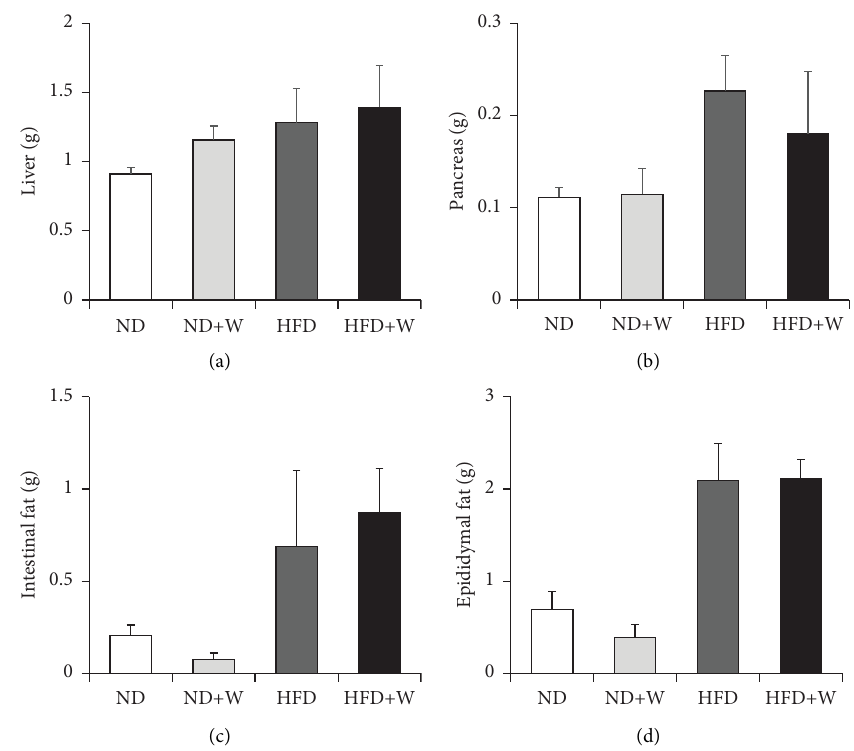
Figure 4: Weight comparison of insulin-sensitive organs and tissues in mice on diferent experimental diets. Seven-week-old C57BL/6J mice were reared on experimental diets for 3 months. Ten, the organs and tissues from the ND, ND+W, HFD, and HFD+W mice were dissected, collected, and measured after 16h of fasting. (a) Liver. (b) Pancreas. (c) Intestinal fat. (d) Epididymal fat. Data are presented as mean ± SD ( n � 4-5 per